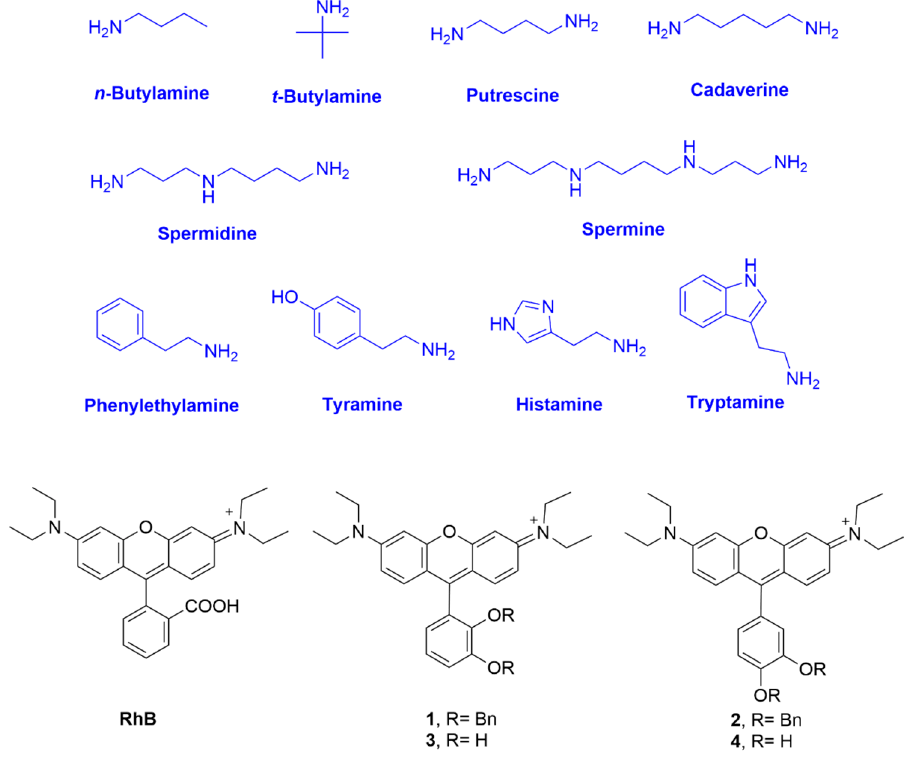
Figure 1. Chemical structures of the biogenic amines used in the studies, RhB and rosamines 1 – 4 .